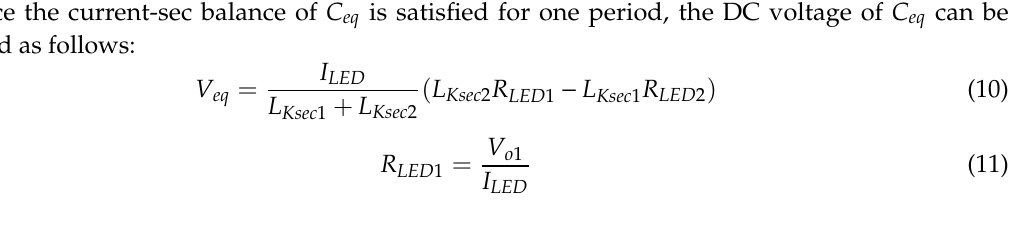
Figure 3. Equivalent circuit during one switching cycle.